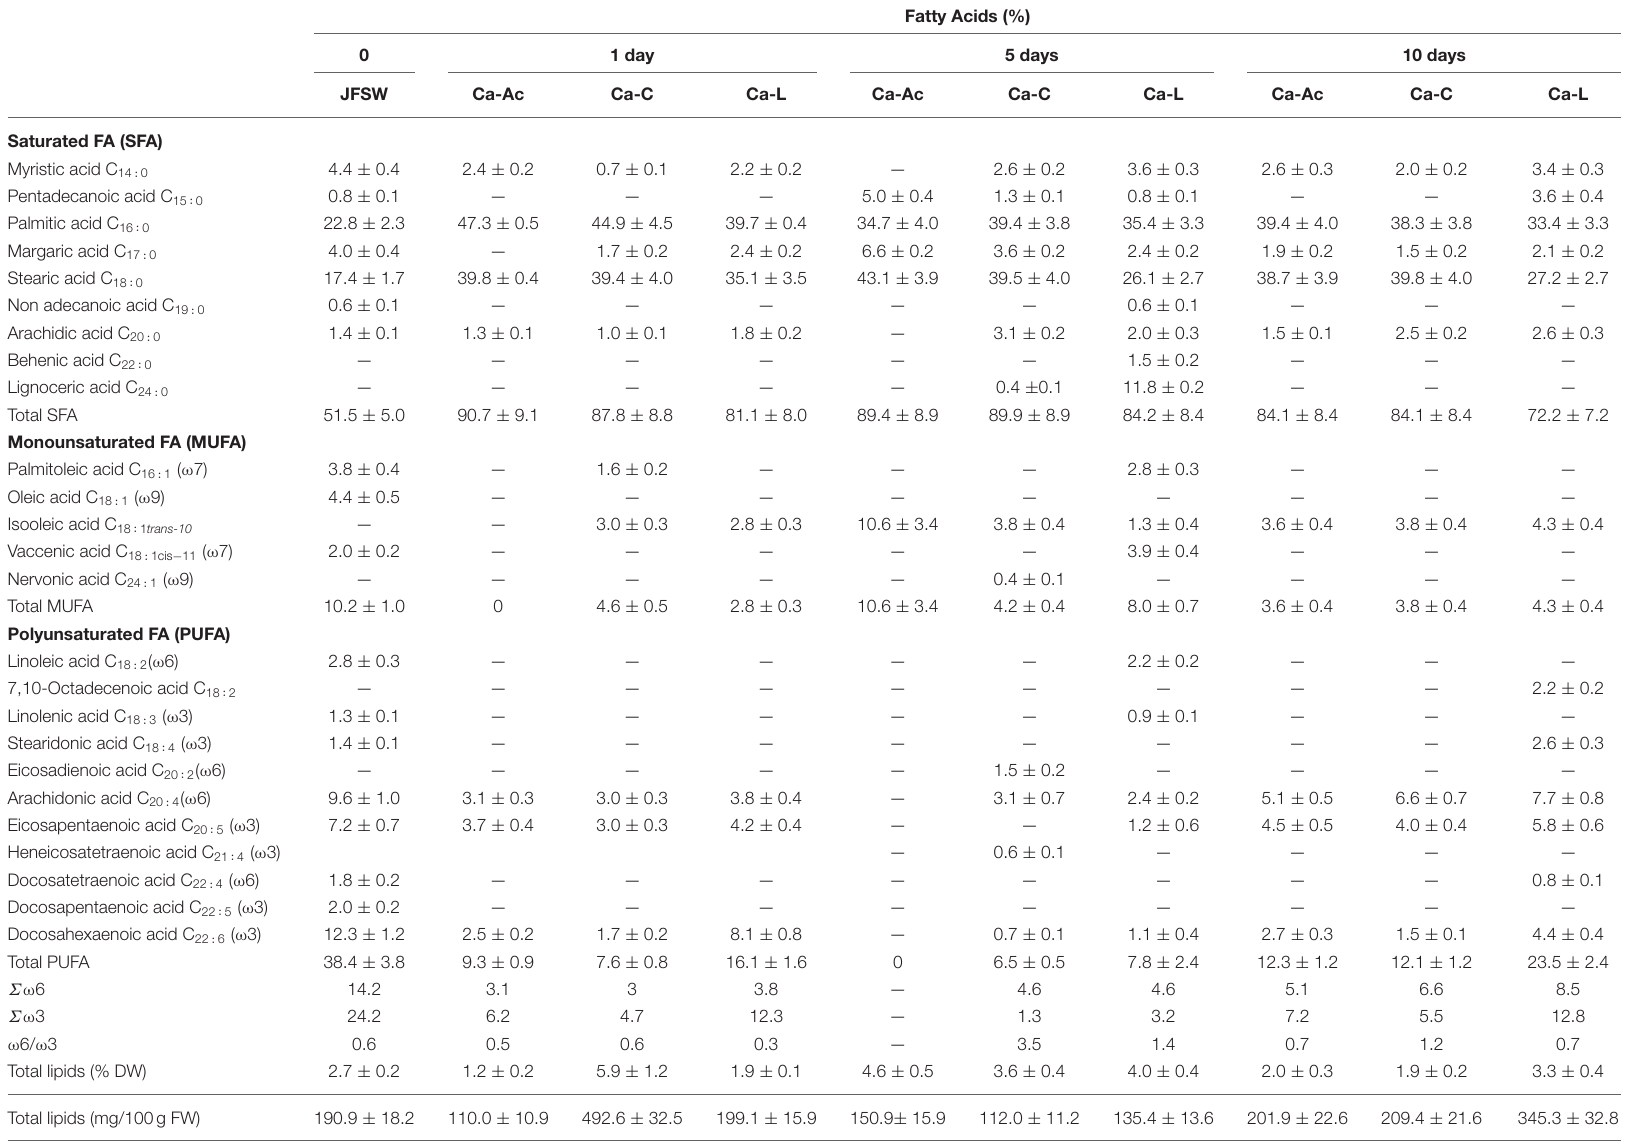
TABLE 4 | Comparison of the fatty acid composition of jellyfish R. pulmo treated with brines containing different calcium salts at 1, 5, and 10 days treatment. Fatty Acids (%) 0 1 day 5 days 10